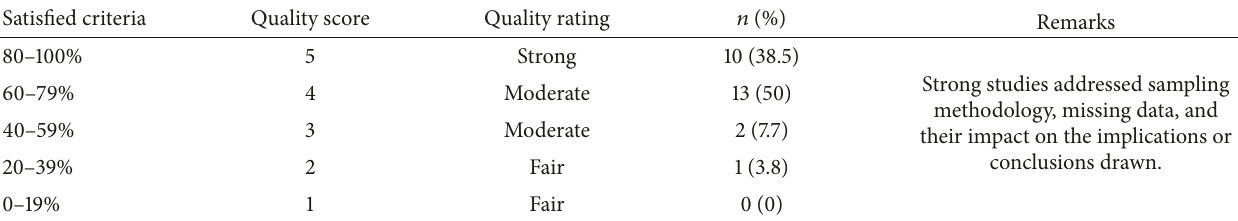
Table 1: Quality assessment